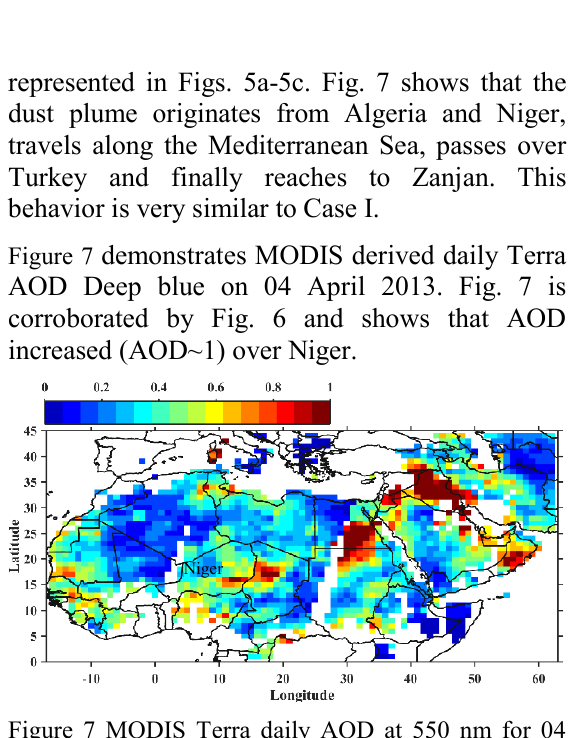
Figure 7 MODIS Terra daily AOD at 550 nm for 04 April 2013, Deep blue AOD for land